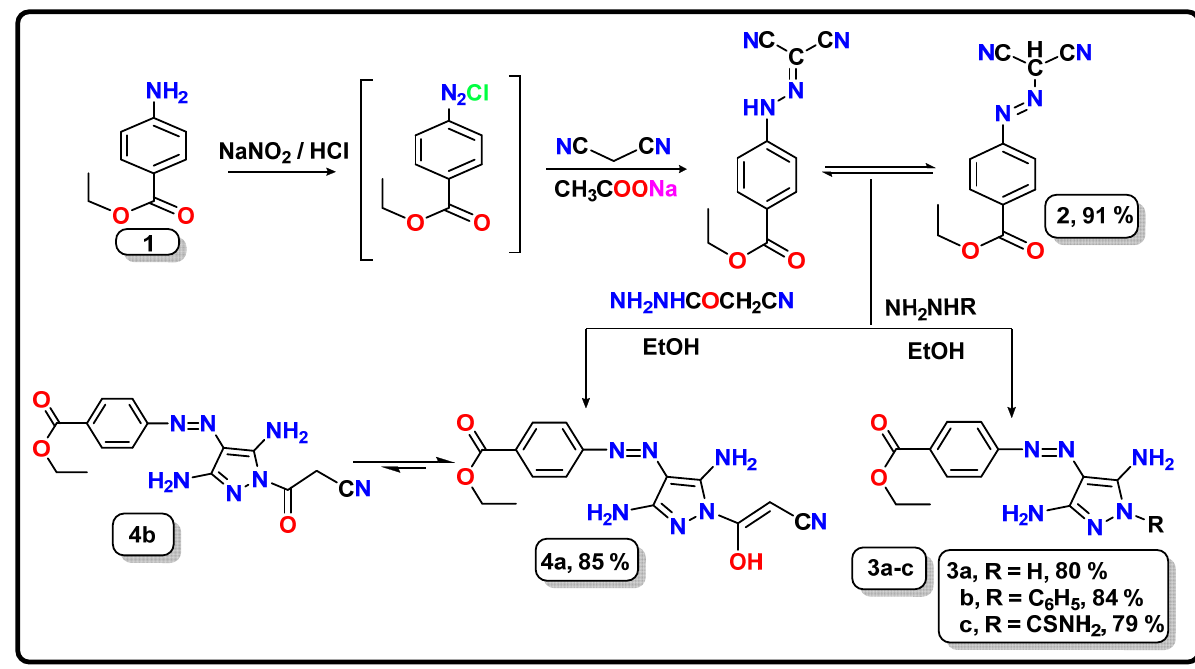
Scheme 1. Illustration of the synthesis of 3,5-diamino pyrazole derivatives 3a–c and 4a,b , starting with the ethyl 4-aminobenzoate moiety.